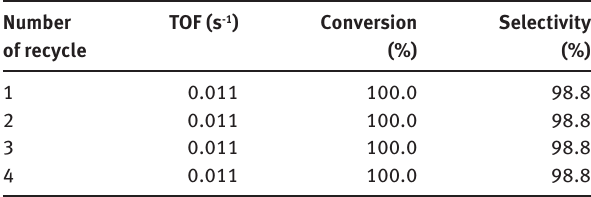
Table 4 Results of the catalyst multiple uses.